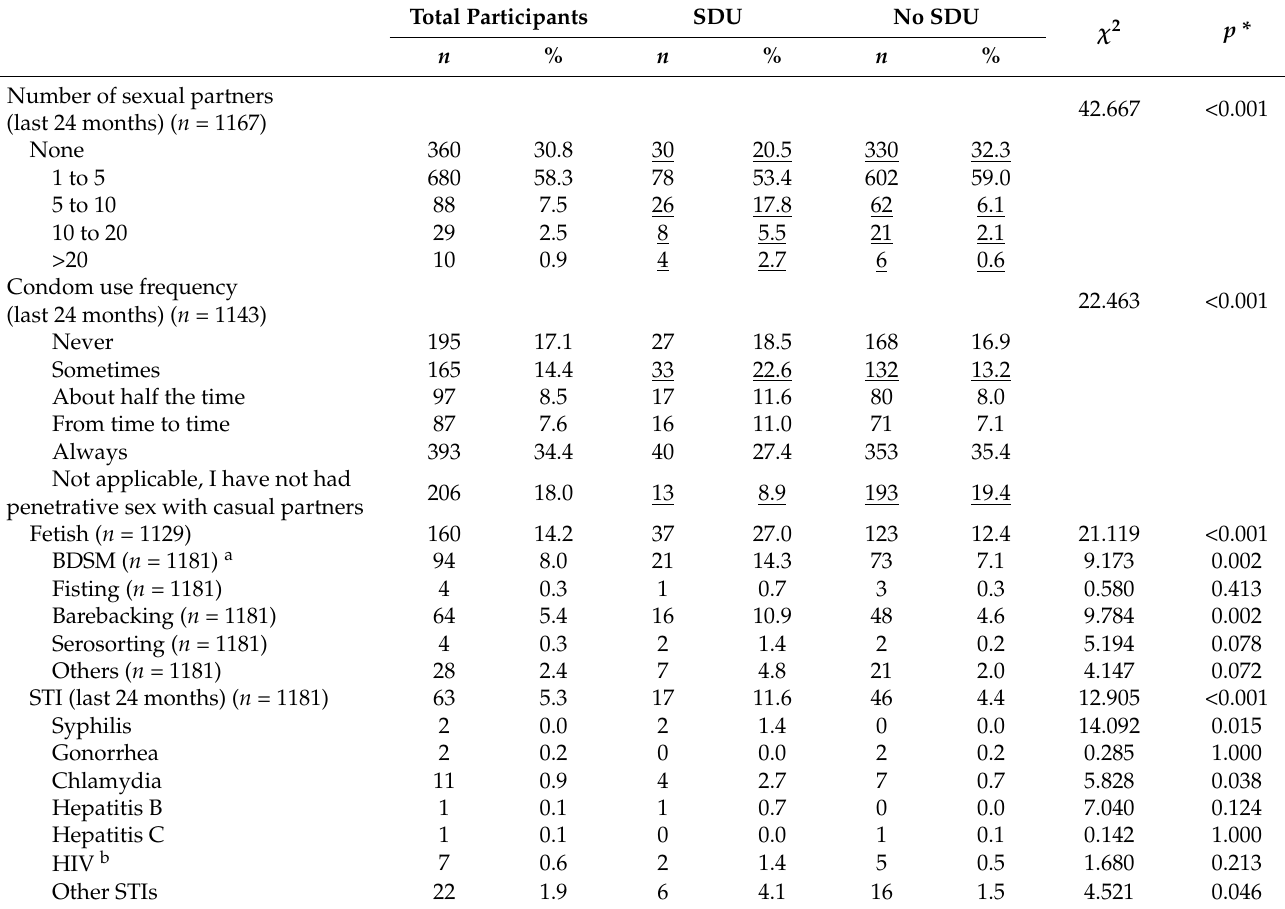
Table 3. Relationship Between SDU and Unsafe Sexual Practices and